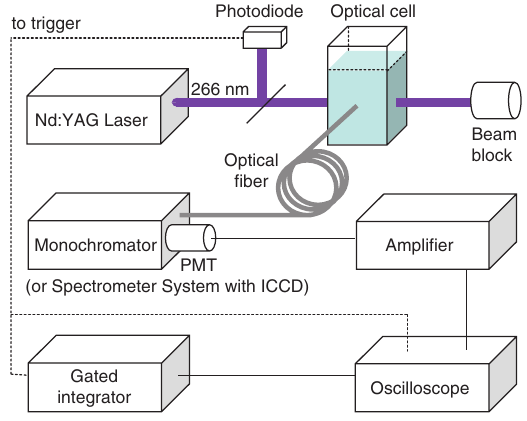
Figure 3 Schematic diagram of the experimental setup for